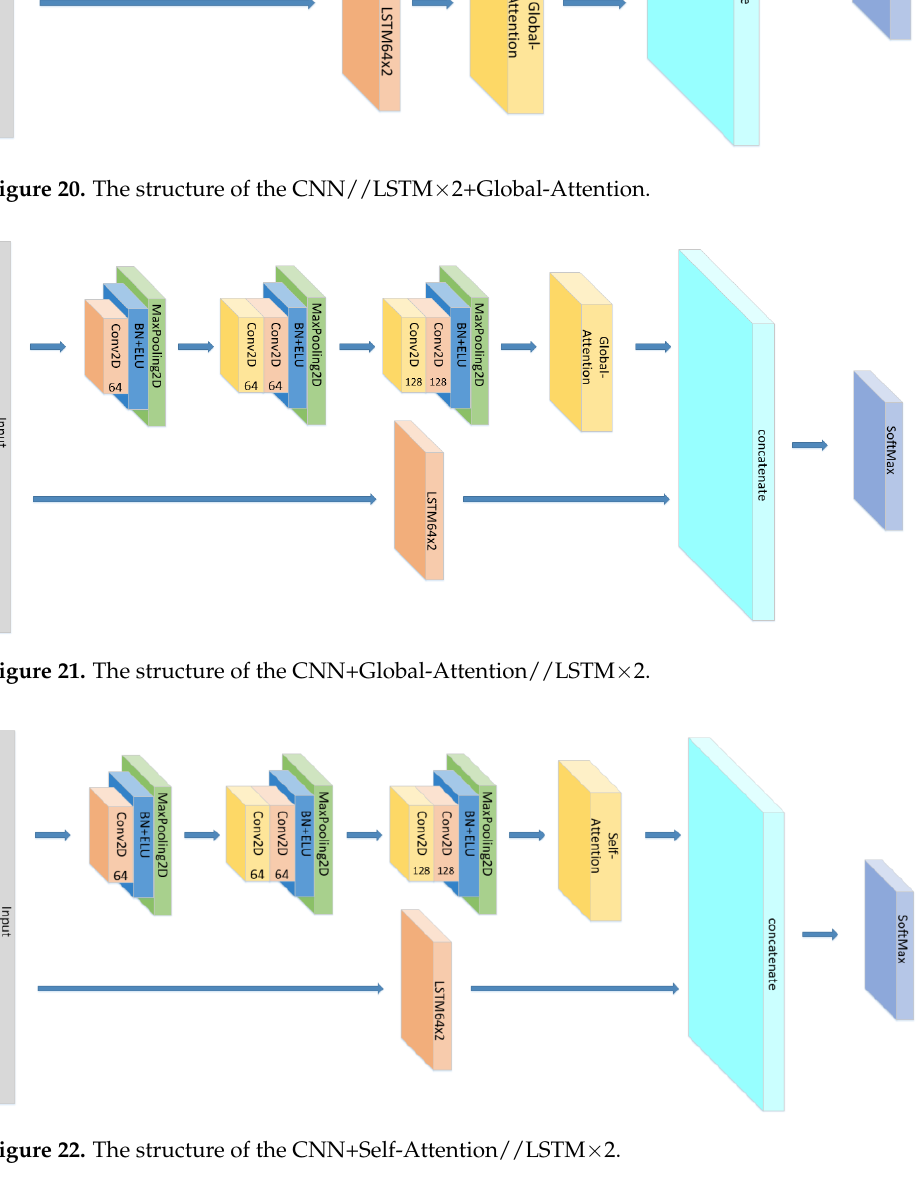
Figure 22. The structure of the CNN+Self-Attention//LSTM×2.